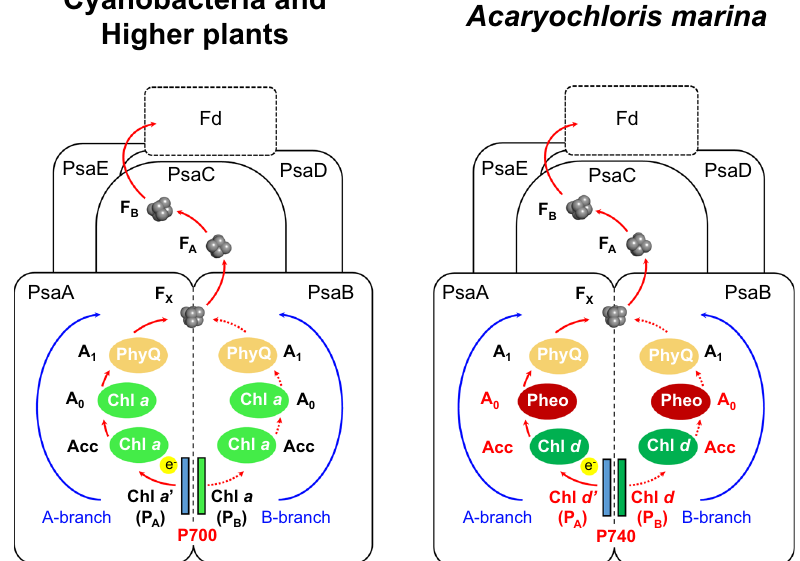
Fig. 1 Comparison of electron transfer chains in PSI. a Cyanobacterial and higher plant PSI. b A. marina PSI identi fi ed in this work. In cyanobacterial and higher plant PSI, electrons released from the paired Chls, so-called special pair, of P700, a heterodimer of Chl a and a ′ , are transferred to ferredoxin (Fd) to reduce NADP + via Acc (Chl a ), A 0 (Chl a ), A 1 (PhyQ), F X (iron – sulfur center), and F A /F B (iron – sulfur center). The components are arranged in a pseudo-C 2 axis on a heterodimer reaction center protein complex (PsaA/PsaB) and the two routes (A- and B-branch located on PsaA and PsaB, respectively) are thought to be equivalent. Acc accessory chlorophyll, A 0 primary electron acceptor, A 1 secondary electron acceptor, F X , F A , and F B iron – sulfur centers, PhyQ phylloquinone. In A. marina PSI, the electron transfer chain is the same, but some cofactors differ from those in the PSIs of other organisms; the Chls of special pair P740 are Chl d / d ′ , while Acc could be Chl d (see text for detail) and A 0 is pheophytin (Pheo) a as PsaI does in T. elongatus . Thus, we concluded that Psa27 and PsaI are in effect the same subunit.